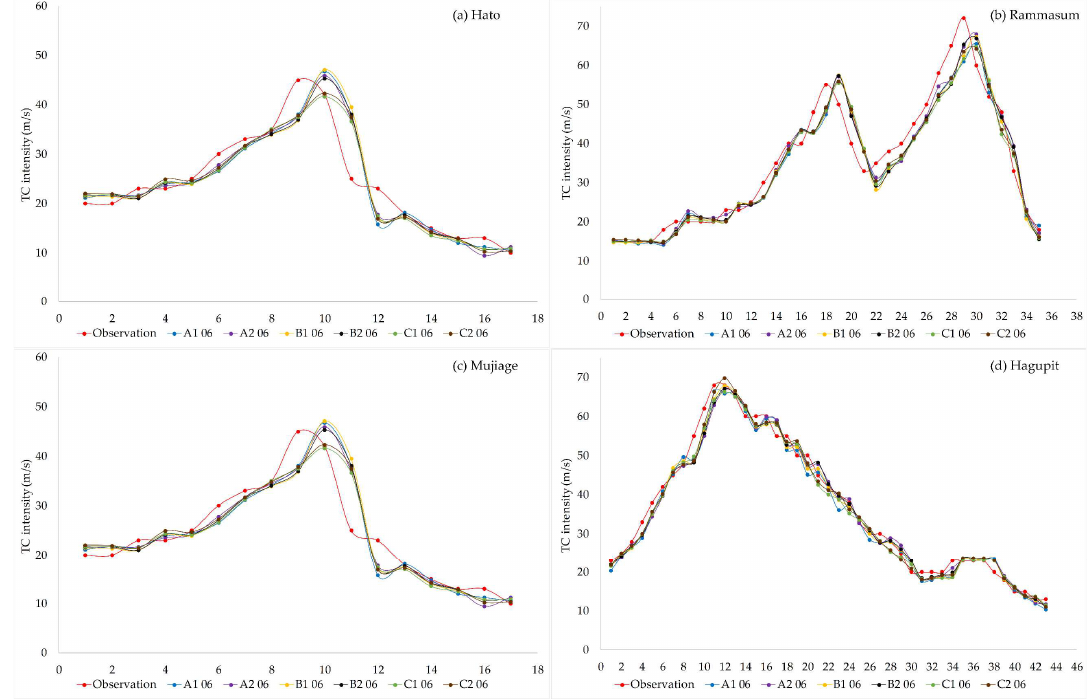
Figure 4. Observed and predicted sequence values of TC intensity with the 6 h lead time for ( a ) Hato, ( b ) Rammasum, ( c ) Mujiage, and ( d ) Hagupit, respectively. The following color coding is used: red (observation), blue (A1, 6 h lead time), purple (A2, 6 h lead time), orange (B1, 6 h lead time), black (B2, 6 h lead time), green (C1, 6 h lead time), and brown (C2, 6 h lead time).